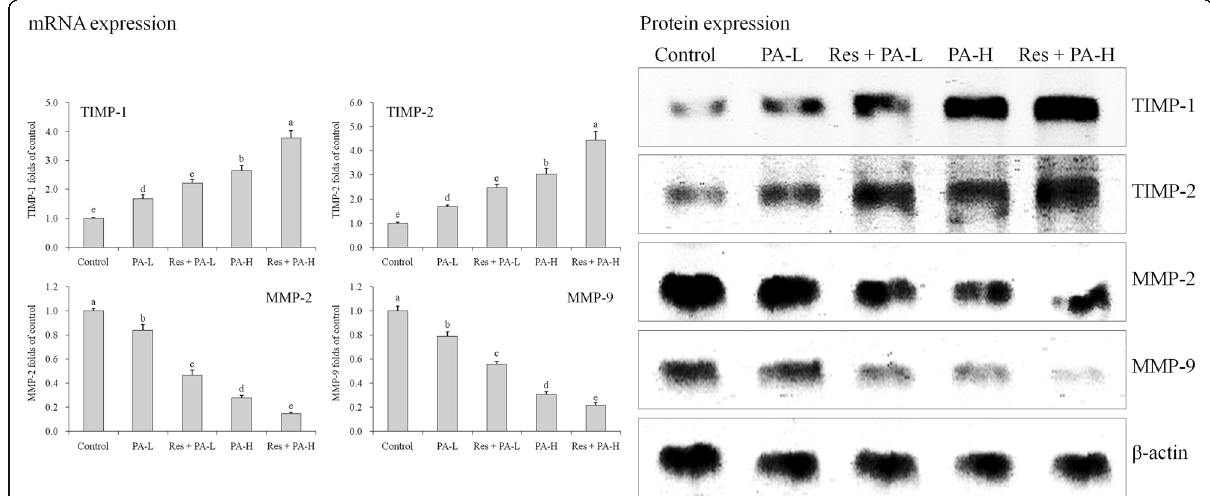
Fig. 11 The mRNA and protein expression of TIMP-1, TIMP-2, MMP-2 and MMP-9 in HepG2 human liver cancer cells. a-e Mean values with different letters over the bars are significantly different ( P < 0.05) according to Dunnett ’ s post-hoc test. PA-L: 5 μ g/mL of paclitaxel; Res + PA-L: 10 μ g/mL of resveratrol +5 μ g/mL of paclitaxel; PA-H: 10 μ g/mL of paclitaxel; Res + PA-H: 10 μ g/mL of resveratrol +10 μ g/mL of